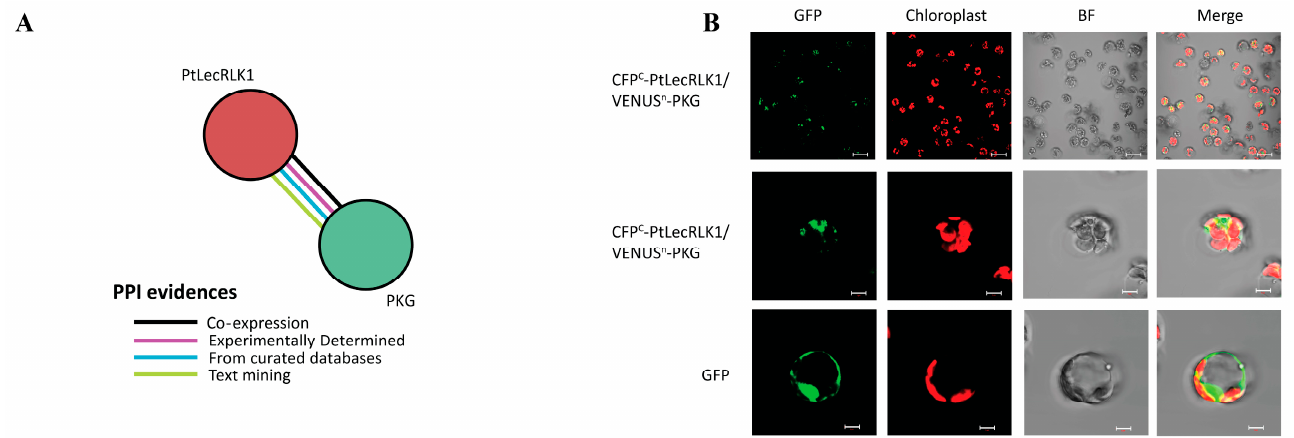
Figure 3. Identification and experimental validation of PtLecRLK1’s interacting partner. ( A ) Protein–protein interaction (PPI) obtained for PtLecRLK1 (Potri.T022200; v3.1) from the STRING database. Different lines of evidence for PPI are represented by different color edges. ( B ) Bimolecular fluorescence complementation (BiFC) assay performed in poplar protoplasts showed PtLecRLK1 and cGMP-PK (PKG) interact with each other as they produce green fluorescence. The scale bars for the top panel represent 40 µm, and the scale bars for the middle and bottom panels represents 5 µm.